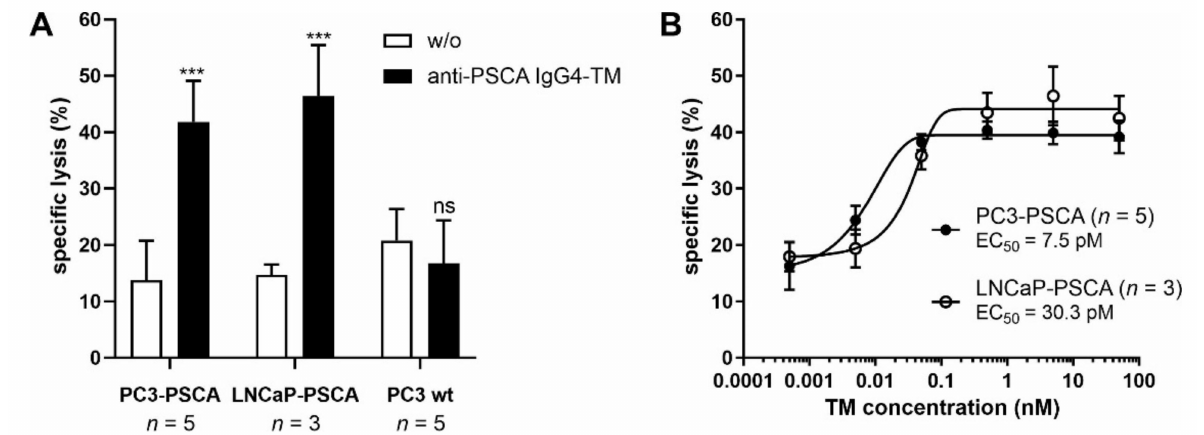
Figure 4. Redirection of UniCAR T cells for tumor cell killing via the novel anti-PSCA IgG4- TM. In 24 h standard chromium release assays, UniCAR T cells were incubated with PC3-PSCA, LNCaP-PSCA, or PC3 wt cells at an E:T ratio of 5:1 in the presence or absence of either ( A ) 5 nM or ( B ) decreasing concentrations of the anti-PSCA IgG4-TM. Mean specific lysis ± SEM of three or five different T cell donors are shown (*** p < 0.001 compared to samples w/o the anti-PSCA